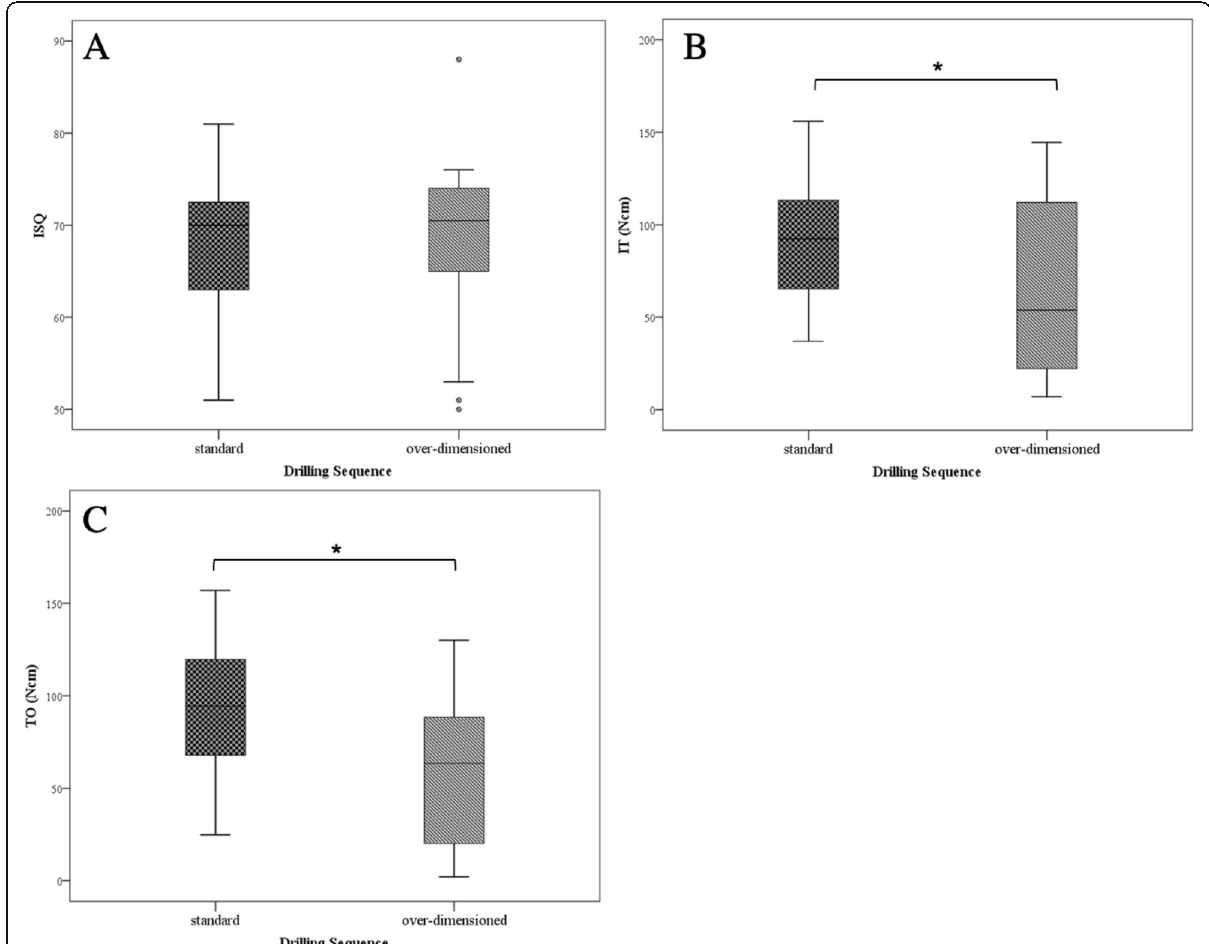
Fig. 3 Comparison of standard and over-dimensioned protocol. The figure displayed shows the comparison between standard and over- dimensioned protocol. a Displays the measurements obtained by RFA. The unit is ISQ with a range of 0 to 100 (minimum to maximum stability). b Displays the results obtained by the torque in and c by the torque out test. Although, there was no statistically significant difference in ISQ between the groups, torque in and torque out tests showed significantly lower values in the over-dimensioned group compared to implant inserted via standard protocol. ISQ, implant stability quotient; IT, insertion torque; TO, torque